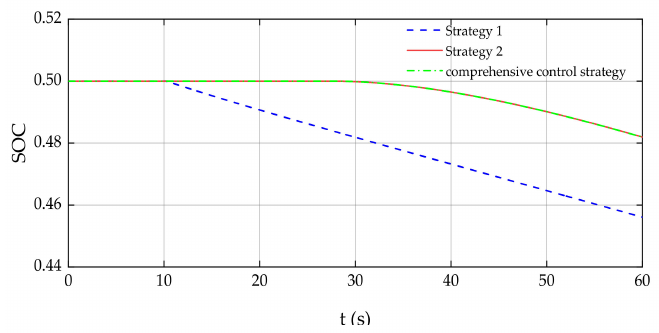
Figure 10. SOC curve of BES under step load